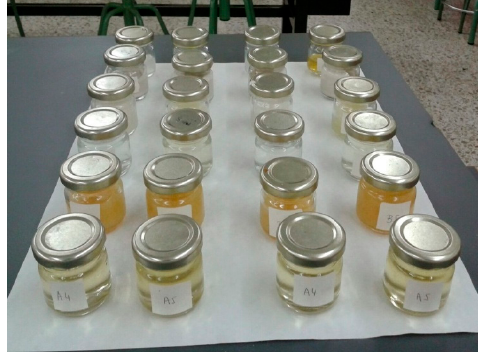
Figure 1. Personal-care products elaborated without extract or with grape pomace, pine wood, acacia flower, and shiitake ethanolic extracts.